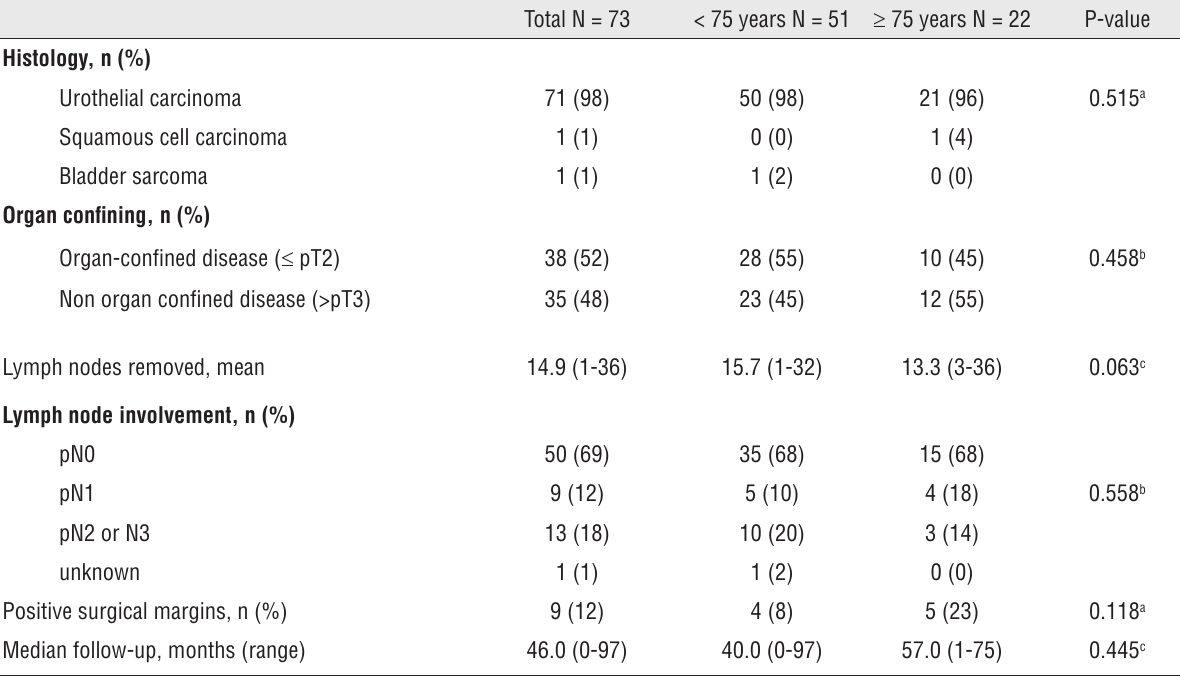
Table 4 - pathology